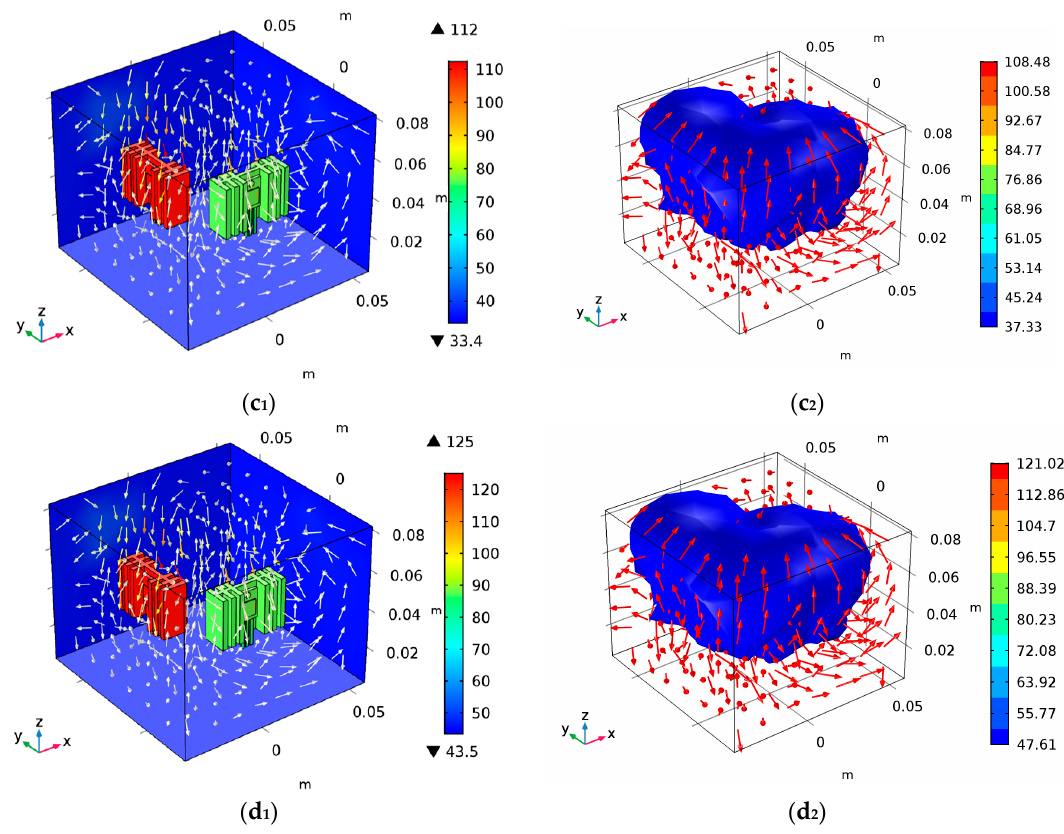
Figure 15. The simulation analysis of convective heat coupling: ( a 1 , a 2 ) are the temperature distribu- tion and iso-surface distribution at T a = 15 °C, ( b 1 , b 2 ) are the temperature distribution and iso-surface distribution at T a = 25 °C, ( c 1 , c 2 ) are the temperature distribution and iso-surface distribution at T a = 35 °C, and ( d 1 , d 2 ) are the temperature distribution and iso-surface distribution at T a = 45 °C.